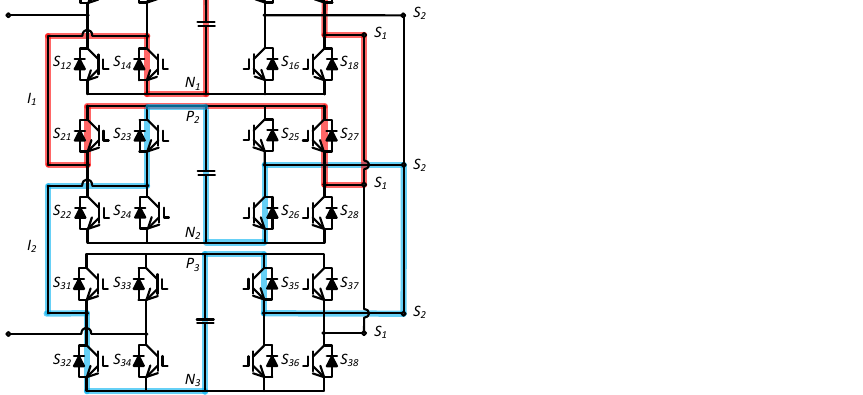
Figure 2. CHB-B2B with 3 modules in the ISOP